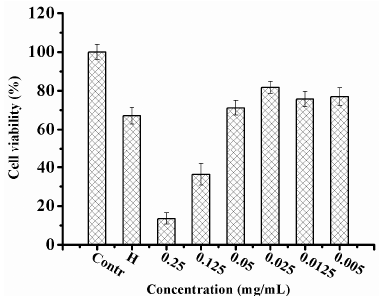
Figure 5. Protective effect of UB-NLC against hydrogen peroxide-induced oxidative stress on HaCaT cells.